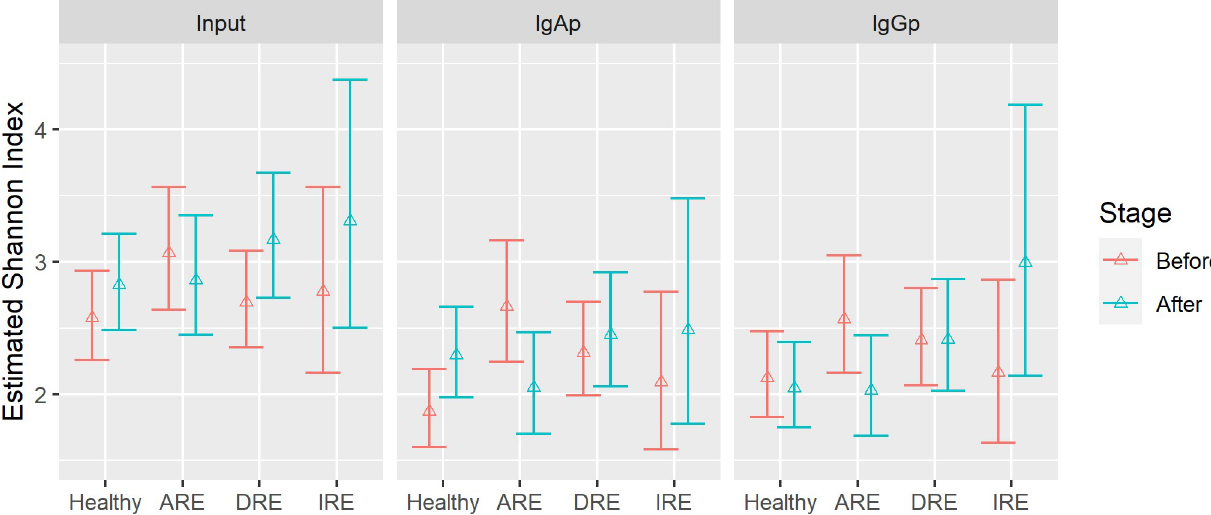
Fig 4. Estimate of the average of the Shannon index for input (pre-sort) immunoglobulin A (IgA) and immunoglobulin (IgG) from healthy dogs and dogs with chronic enteropathy (CE). DRE: Diet-responsive enteropathy. ARE: Antibiotic-responsive enteropathy. IRE: Immunosuppressant- responsive enteropathy. ‘Before’ corresponds to V1 in healthy dogs and active disease in CE dogs. ‘After’ corresponds to V2 in healthy dogs and remission in CE